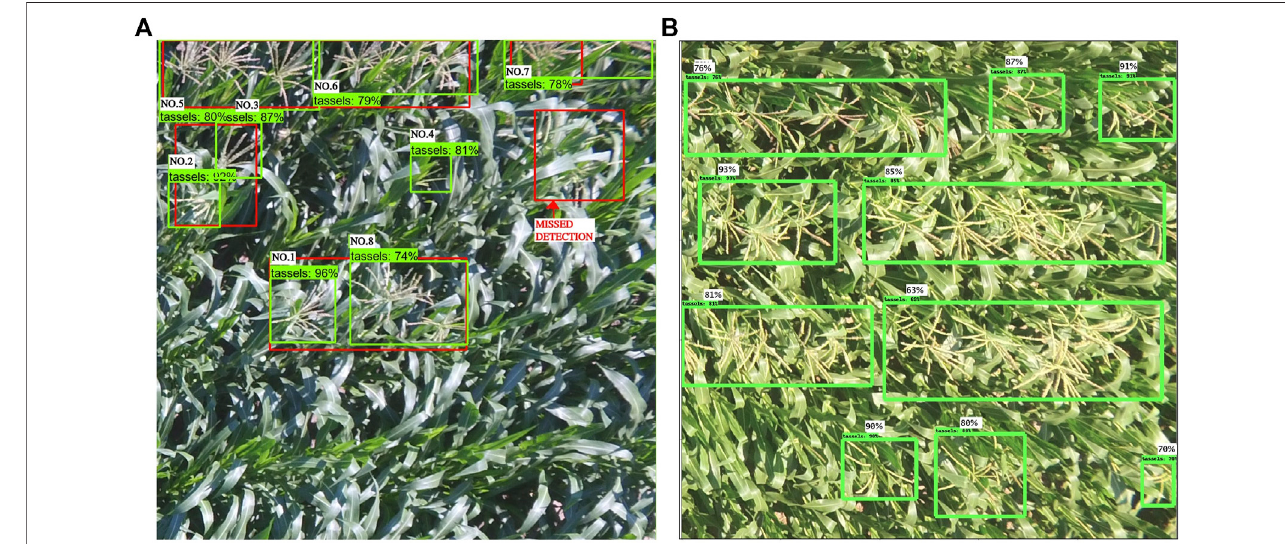
FIGURE 5 | [Best viewed in color] (a) Faster R-CNN output with a low precision value (2%), although all ground truth were detected except one (green box: the model detection and red box: ground truth). (b) Faster R-CNN output all of correct tassels.